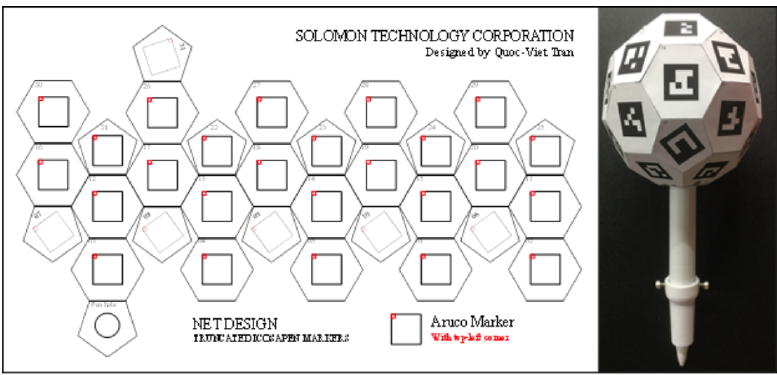
Figure 4. Truncated Icosapen Net with ArUco